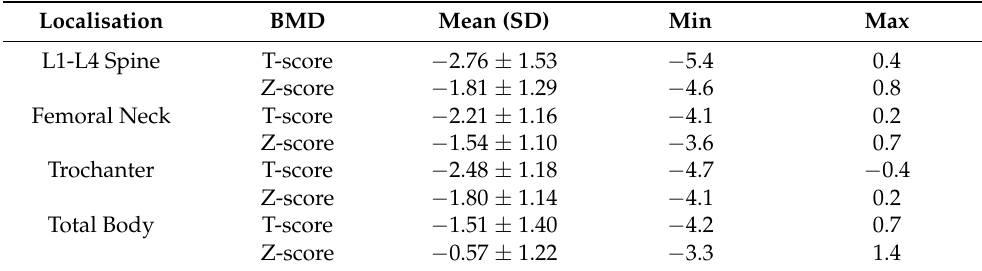
Table 1. Initial bone mineral density (BMD).